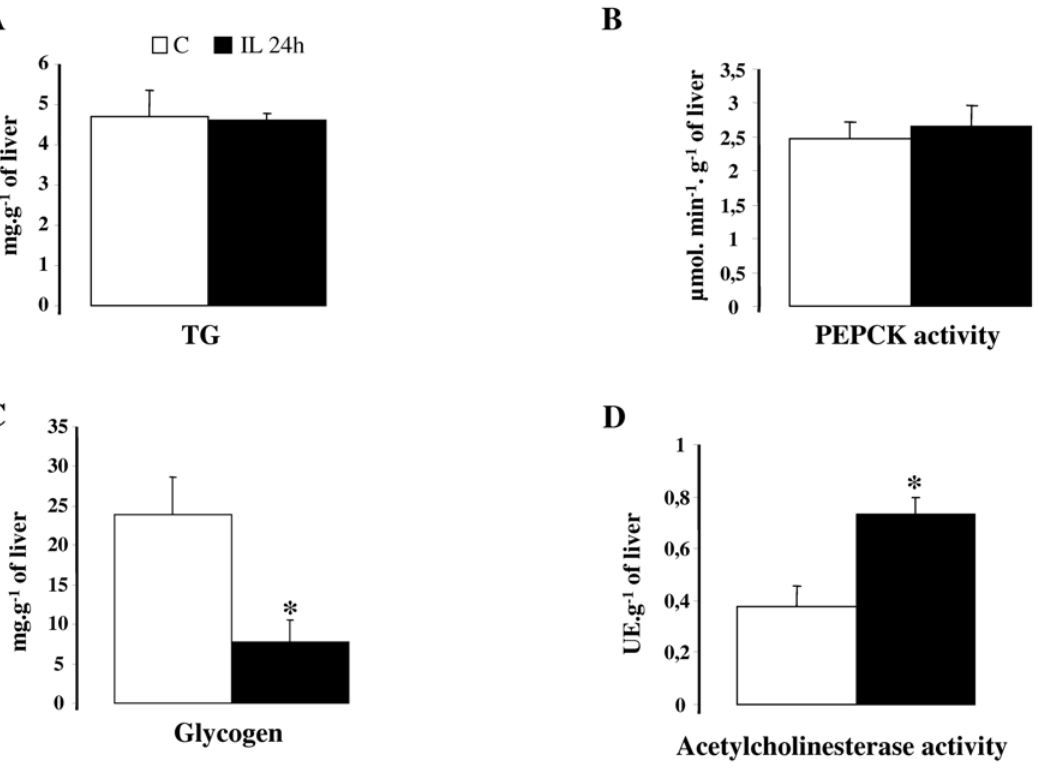
Figure 3. Hepatic parameters after 24 h of infusion in C rats (NaCl/heparin) and in IL rats (IL/hep). A: liver triglycerides content, B: liver PEPCK activity, C: liver glycogen, D: liver acetylcholinesterase activity. Values are means 6 SEM in each group. * p , 0.05 vs.